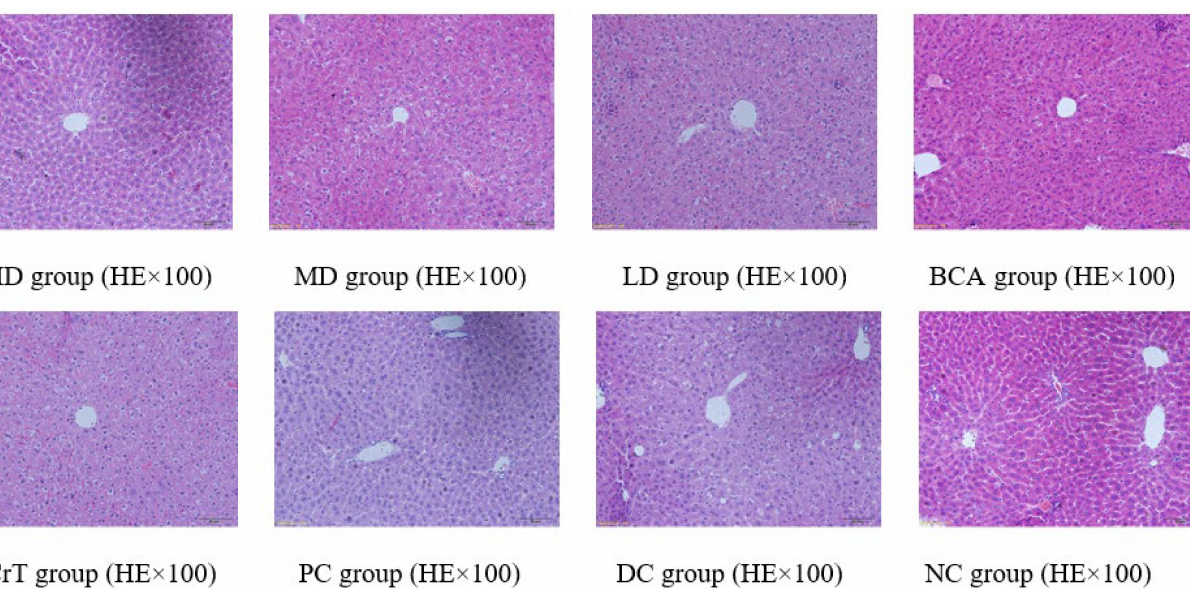
Figure 10. ITT in each group of mice. Values are means ± SD ( n = 7). The differences between these groups and the DC group were statistically significant (denoted by “*” for p < 0.05).